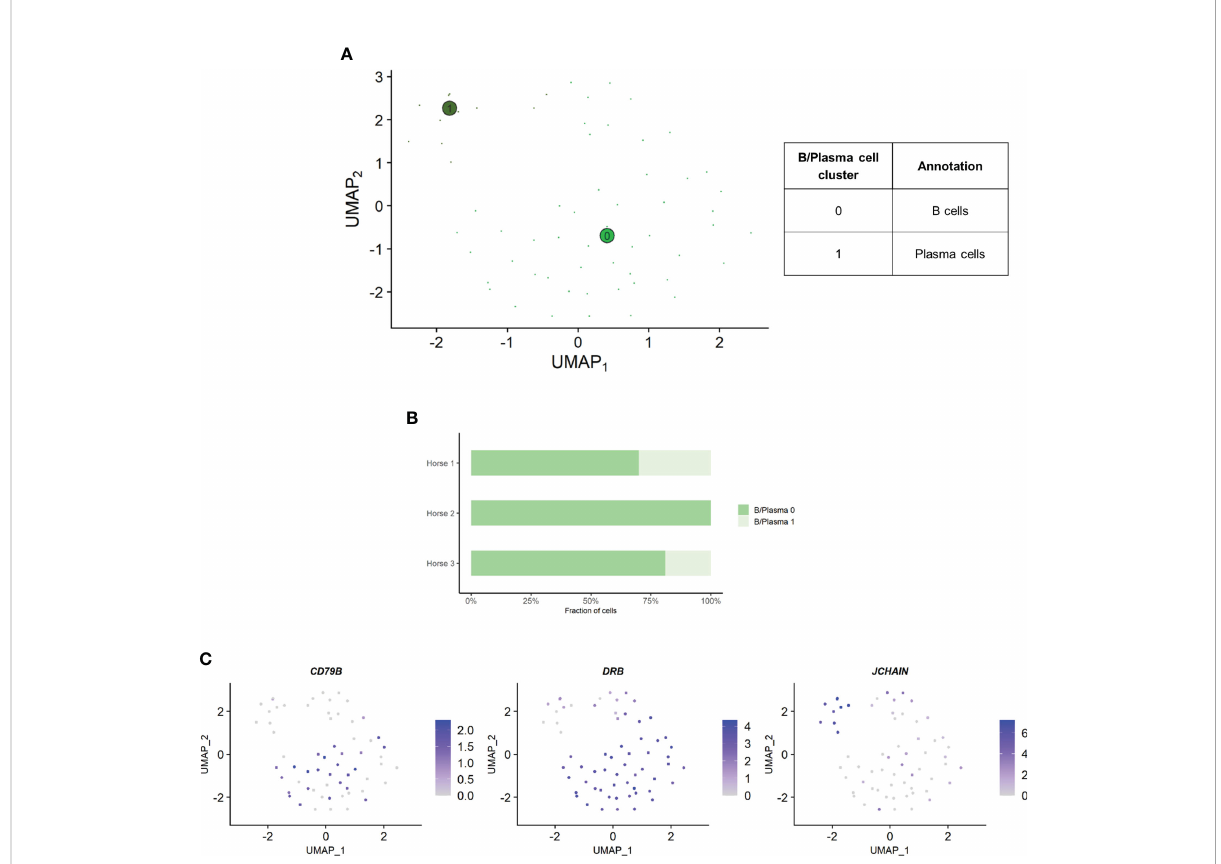
FIGURE 6 Independent analysis of the B/plasma cell population (n=62 cells) (A) UMAP visualization of the two B/plasma cell clusters identi fi ed, with suggested cluster annotation. (B) Distribution of the B/plasma cell clusters for each horse, based on scRNA-seq analysis. (C) Gene expression patterns used for cell subtype assignment. *LOC100147624 annotated as derlin 3 (DERL3) (NCBI EqCab3.0